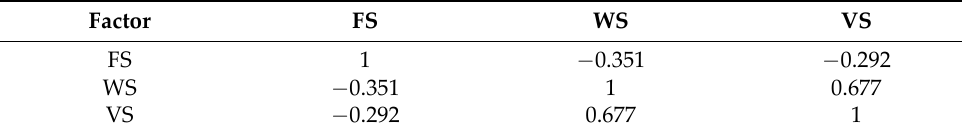
Table 4. Matrix representation of the ESST in the Manas River Basin.